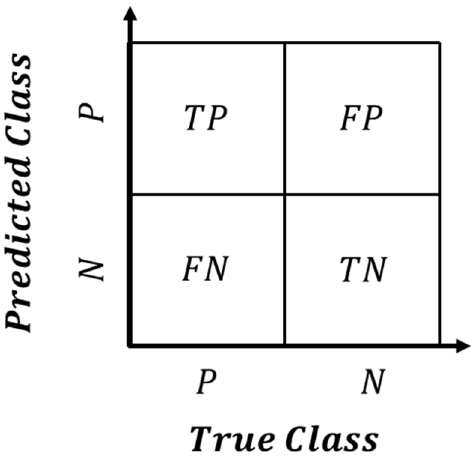
Figure 7. Representation of classification model result in confusion matrix.